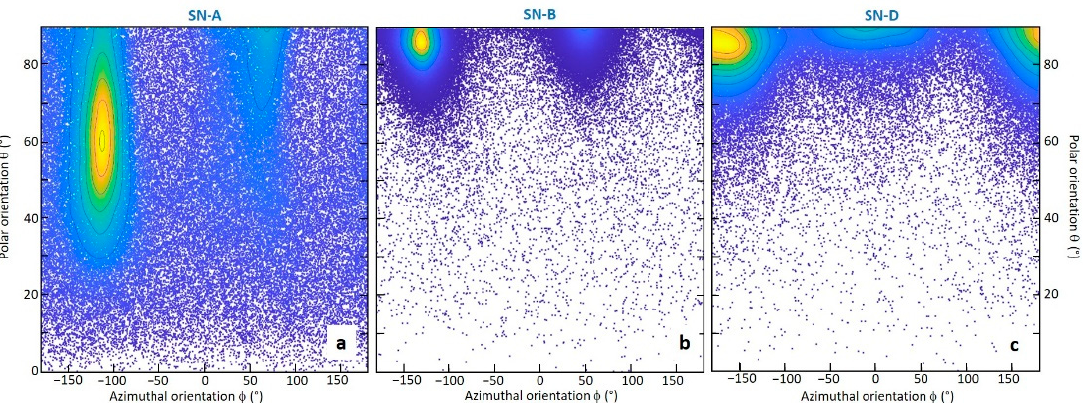
Figure 7. Scatterplot of the azimuthal and polar orientation of the major axes of the vesicles. The reference system is shown in Figure 5. A density function has been overlapped to the scatter plots to highlight the preferential orientation(s). Yellow indicates the highest concentration of points, blue the lowest. ( a ) Sample SN-A; ( b ) sample SN-B; ( c ) sample SN-D.